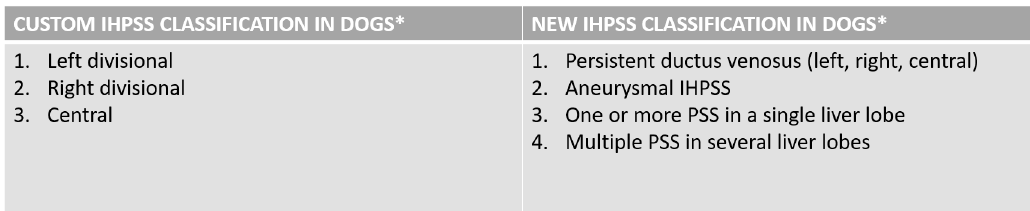
Figure 10. On the left, current classification of intrahepatic portosystemic shunt in dogs [54–56]. On the right, the new classification proposal. Four different phenotypes are possible. The persistent ductus venosus is the most commonly encountered IHPSS. It can be anatomically left, right or central located. Other complex IHPSS are increasingly recognized with CT and may involve one or more liver lobes, as already described in children [7,57].